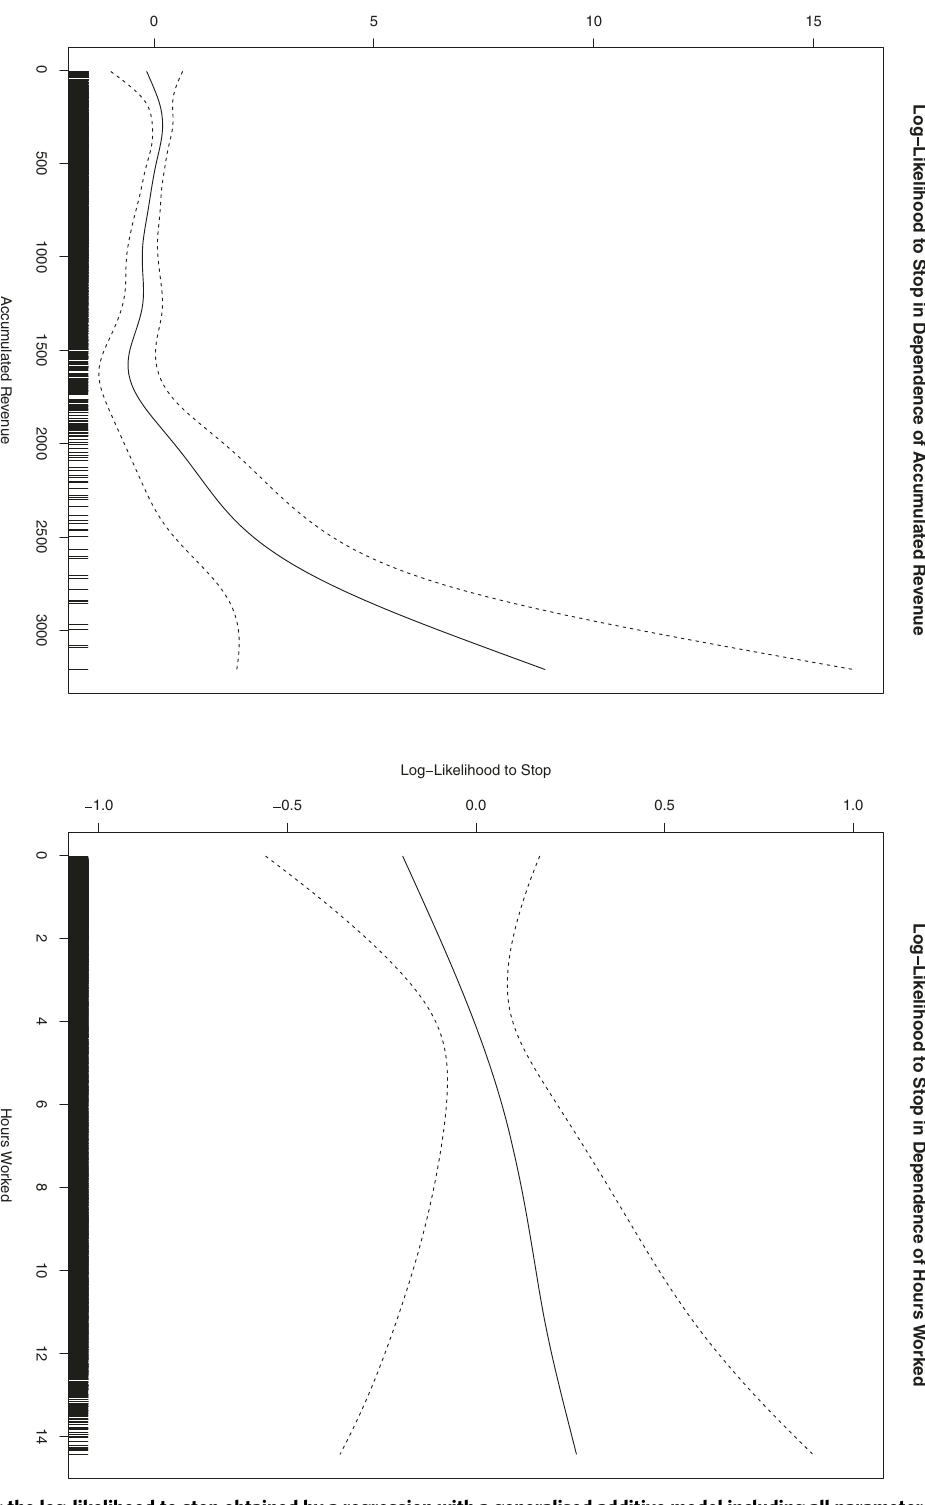
Fig. 2 Line indicating the log-likelihood to stop obtained by a regression with a generalised additive model including all parameters, with the exception of revenues accumulated and hours worked which were chosen as variables to smooth over. Hour fi xed effects were included. 95% con fi dence interval included. Smoothing parameter of 7.59 chosen for accumulated revenues and 1.322 for hours worked. See more particular regression results for smooth terms in Table A.5. Source: Own representation, Data: GoMetro